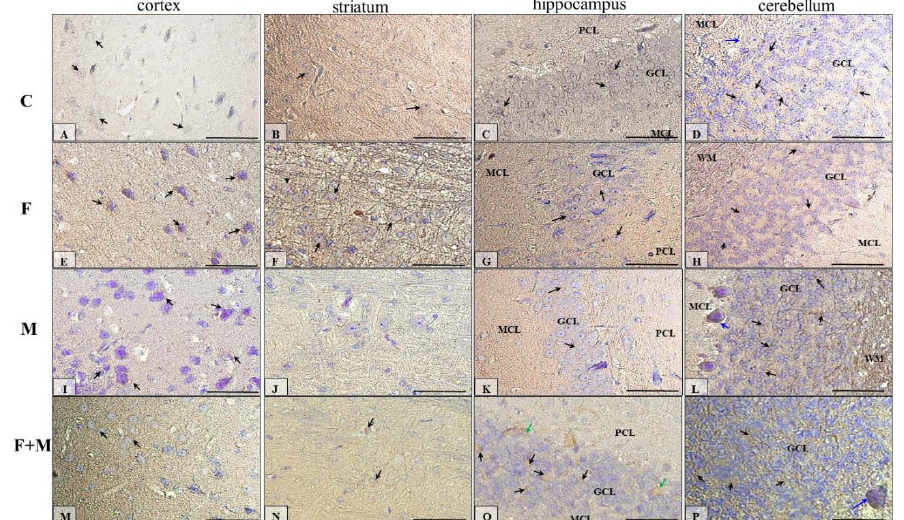
Figure 5. Representative microphotography showing immunoexpression of dopamine receptor D1 in the cortex ( A , E , I , M ), striatum ( B , F , J , N ), hippocampus ( C , G , K , O ), and cerebellum ( D , H , L , P ) of rats in the control ( A – D ), fluoride ( E – H ), morphine ( I – L ), and morphine and fluoride ( M – P ) groups. IHC reaction. Scale bar 50 μ m. GCL—granular cell layer, MCL—molecular cell layer, PCL—polymorphic cell layer, WM—white matter. Black arrows—neurons of neocortex or striatum or GCL from the hippocampus or cerebellum, green arrows—neurons of PCL of the dentate gyrus, blue arrows—Purkinje cells of the ganglion cell layer of the cerebellar cortex.